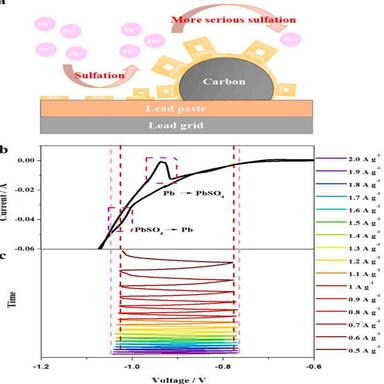
(a) the schematic diagram of the lead ion behavior on the carbon coating negative electrode. (b) the CV diagram of carbon materials in saturated lead sulfate / 4.7 M sulfuric acid mixed solution. (c) the floating test of the negative electrode during the cycling of ultra-battery between 0.5 A g− 1 and 2 A g− 1 .